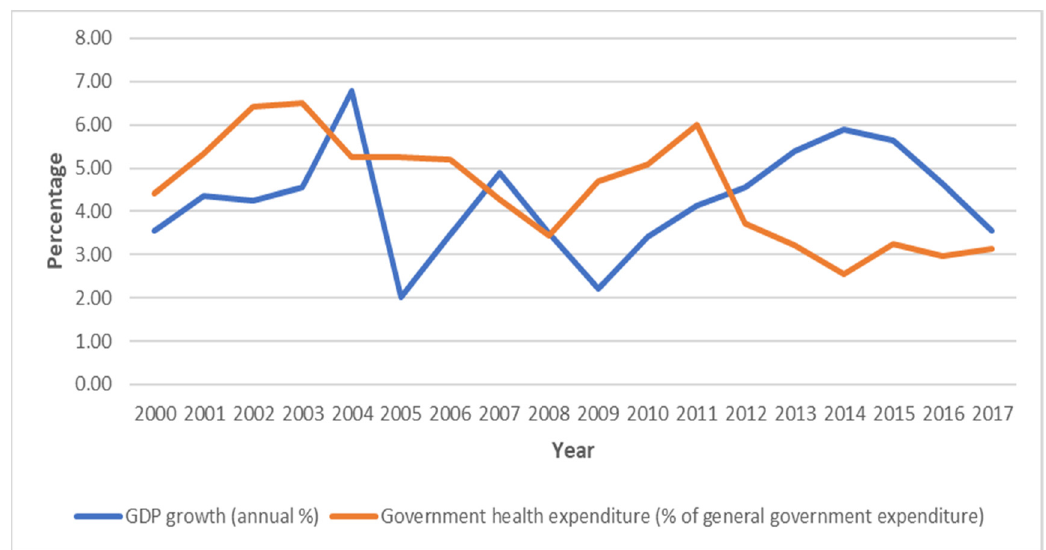
Figure 1. GDP growth and government health expenditures in the period 2000–2017. Source: author’s computation based on data from World Development Indicators database.